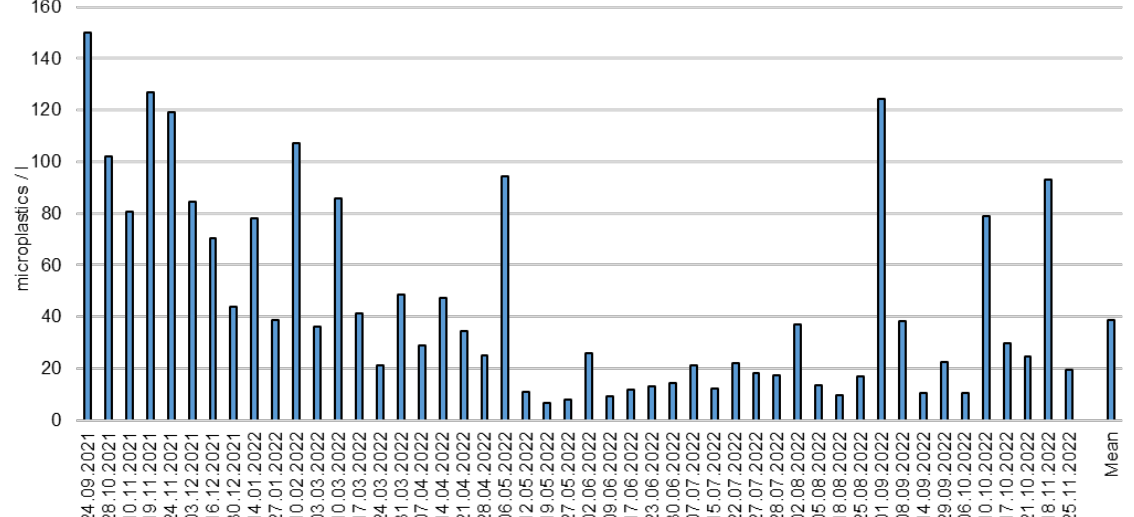
Figure 6. Results of the long-term monitoring of the microplastic contamination in the WWTP effluent. The samples were measured in duplicates and the average was calculated.